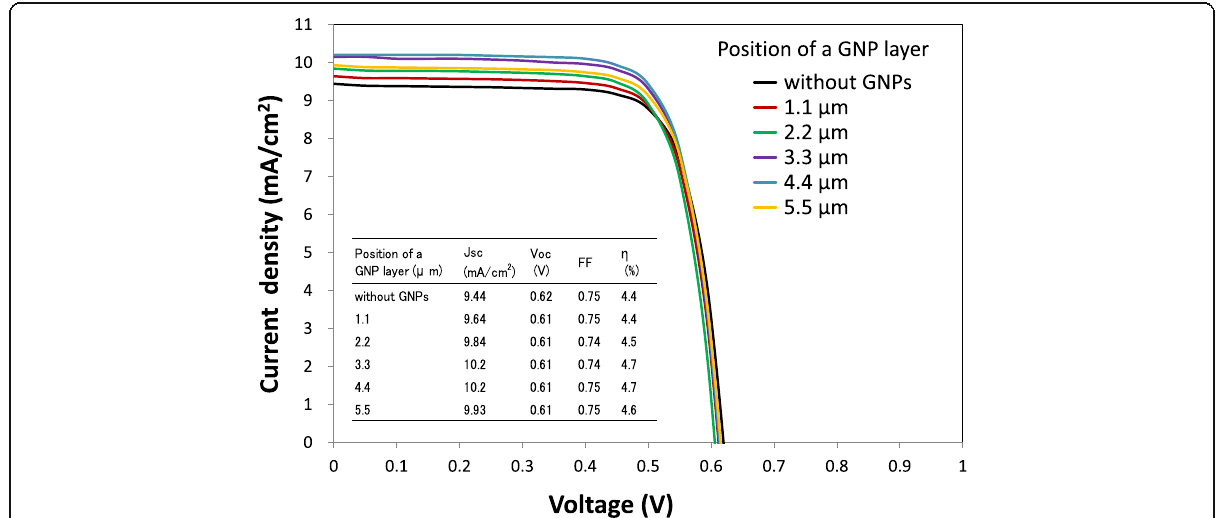
Fig. 8 Current density – voltage curves of the DSSCs with varying the position of a GNP layer. The density of GNPs is 2.7 μ g/cm